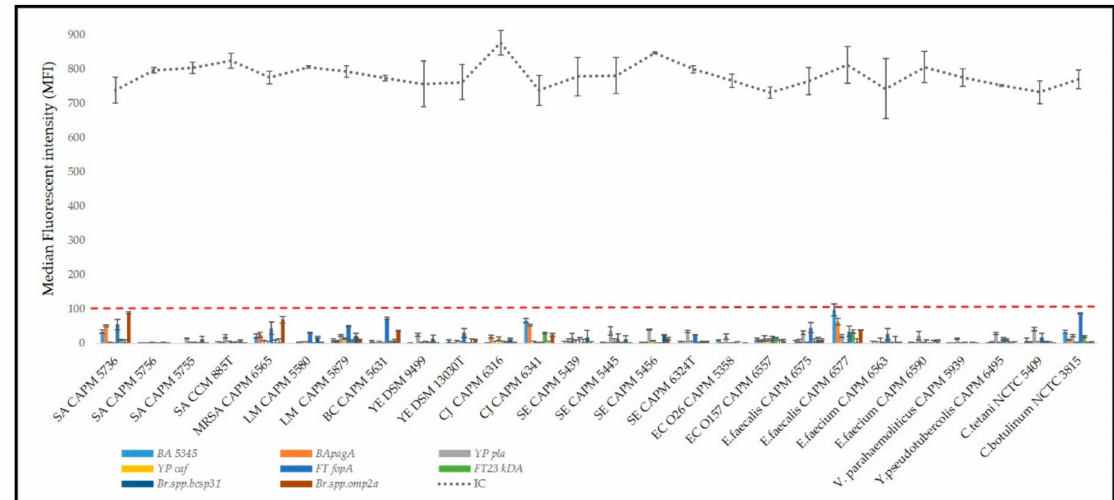
Figure 3. Exclusivity of biothreat detection panel based on MOL-PCR method. The exclusivity test was performed on various bacterial strains (Table 1) and evaluated as MFI. The specificity of the probes used in the biothreat panel was confirmed by the values obtained being below 100 MFI when using unrelated DNA. An IC confirmed the correct course of the MOL-PCR reaction.